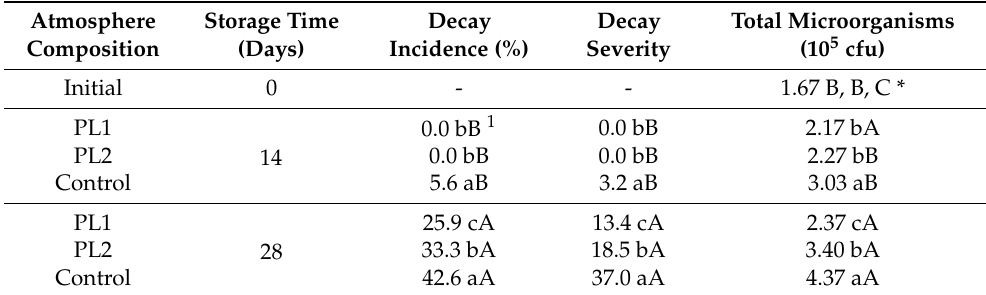
Table 3. Decay incidence, decay severity and total microorganisms of Bursa Siyahi fig cultivar under palliflex system during the cold storage.